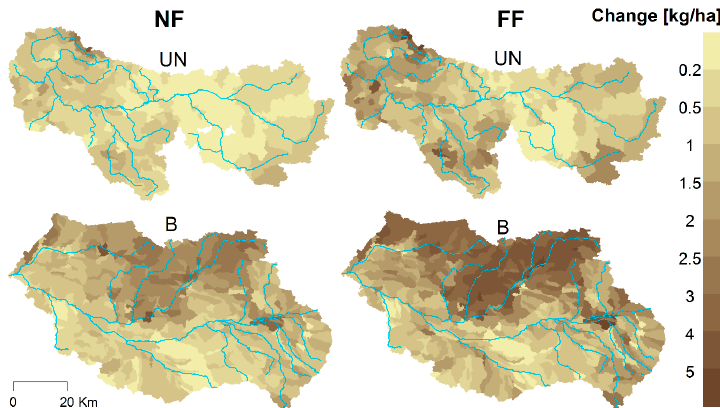
Figure 12. Projected change in TN losses (TN transported by all types of pathways from sub-basins to streams) in the Upper Narew and Barycz catchments in the near and far future according to the ensemble median.